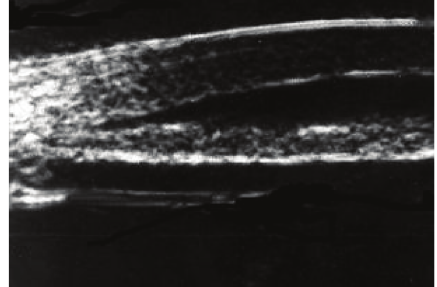
Figure 3: Ultrasound biomicroscopy image of left eye showing hyperplasia of ciliary